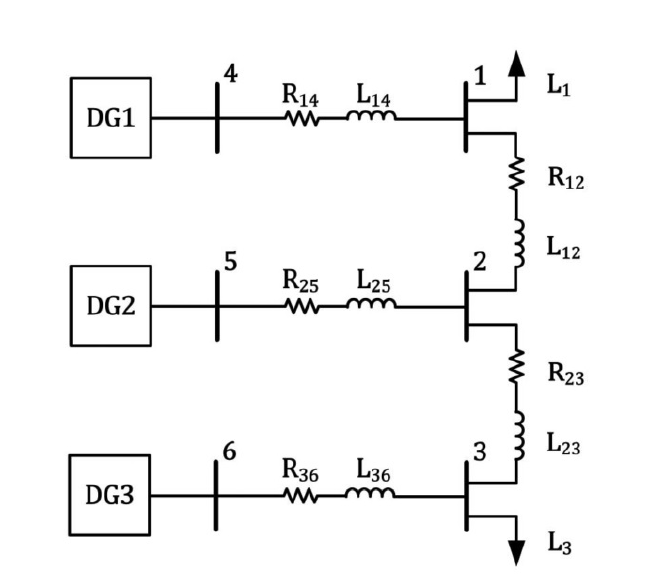
Figure 2. Six-bus MG [17]. Table 2. Data required for modeling the six-bus test system in the time domain.